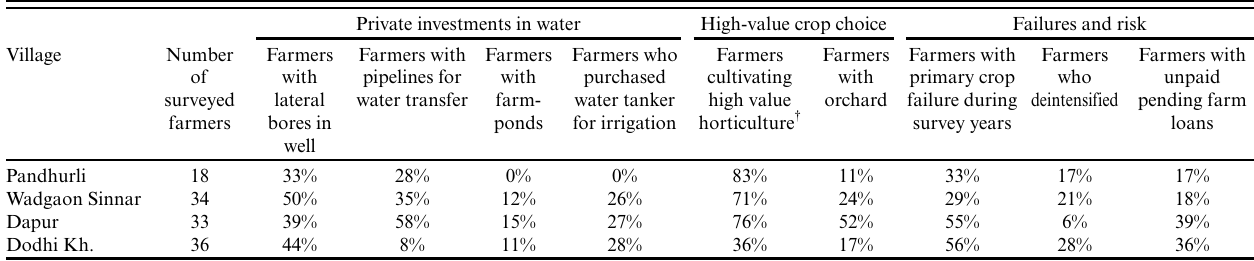
Table 2 . Summary of investments in water infrastructure, high-value horticulture cultivation, and outcomes. Private investments in water